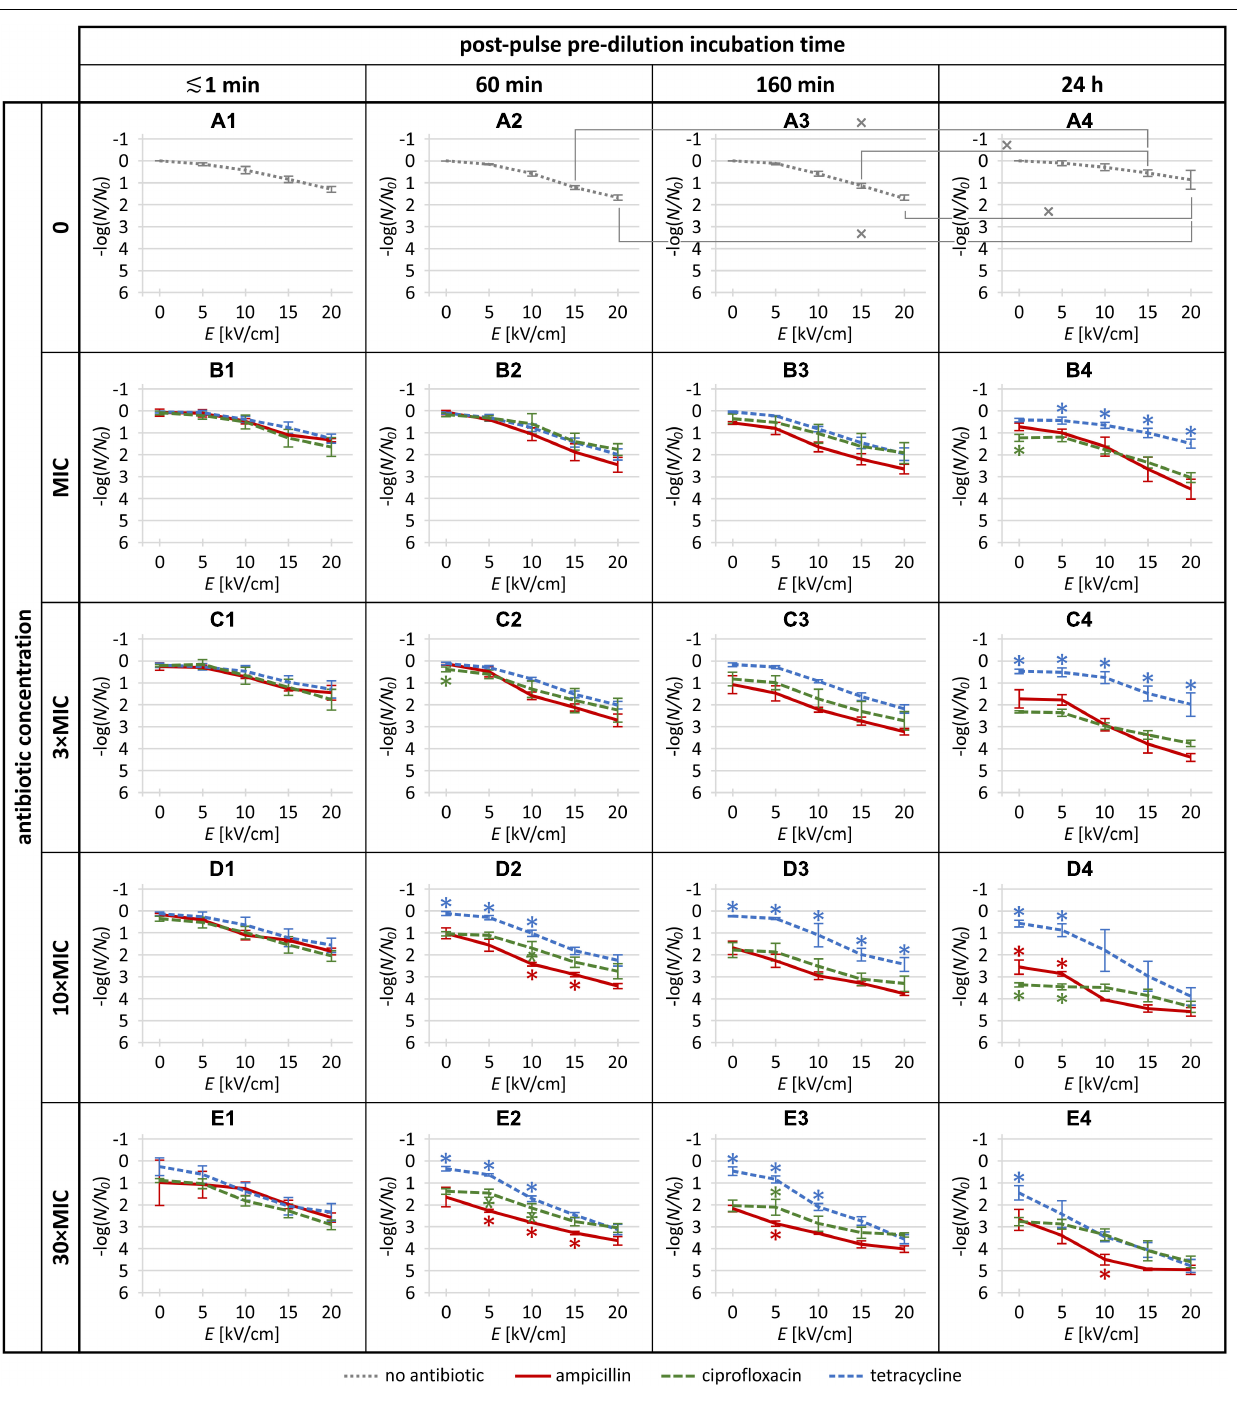
Frontiers in Microbiology |